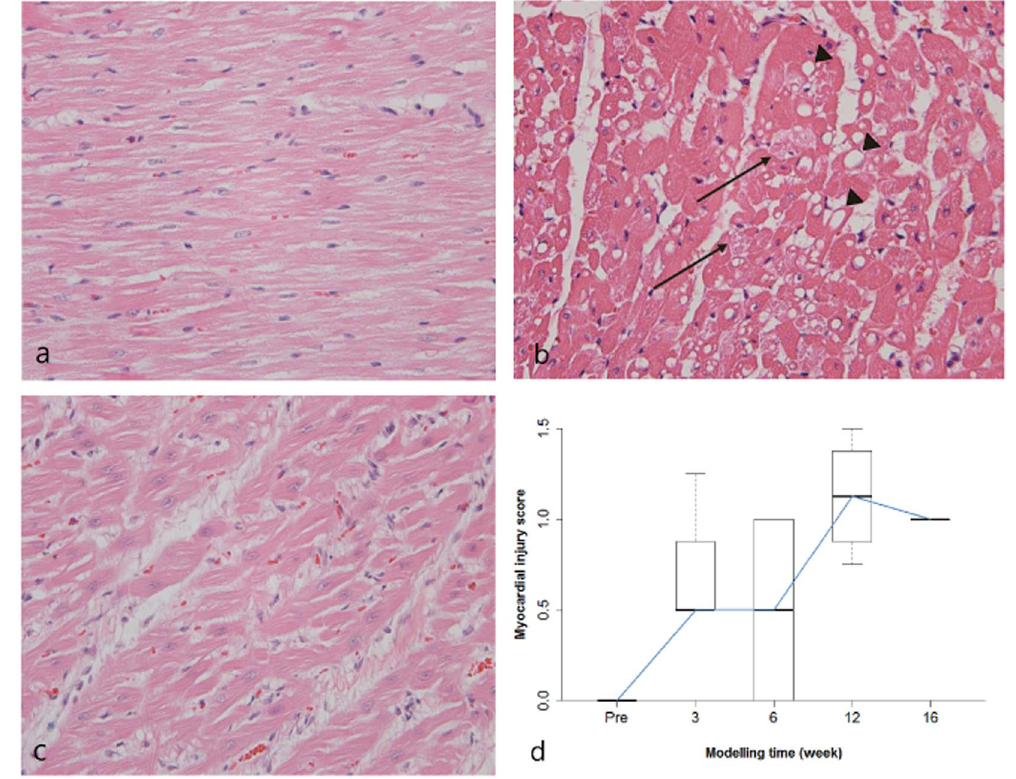
Figure 3. Histological findings of myocardial injury. ( a ) Normal myocardium from a control subject. ( b ) Severe myocardial injury with intracytoplasmic vacuolization (arrowheads) and myofibril loss (arrows) are visible in the left ventricular (LV) septal wall of a 3-week model (myocardial injury score = 3). ( c ) Diffuse interstitial oedema is visible in the LV lateral wall of a 3-week model. Haematoxylin and eosin staining; magnification, × 400 ( d ) Myocardial injury score according to the modelling time.